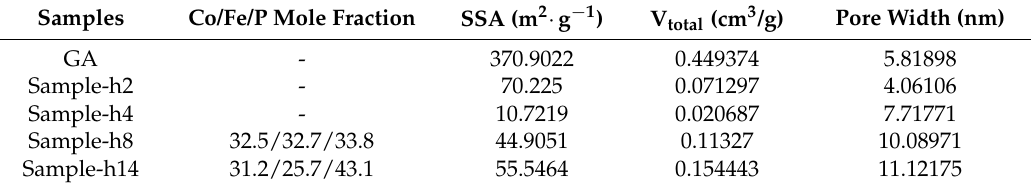
Table 1. The composition, specific surface area (SSA) and volume (V total ), and pore width of GA and GA/Co-Fe-P samples.